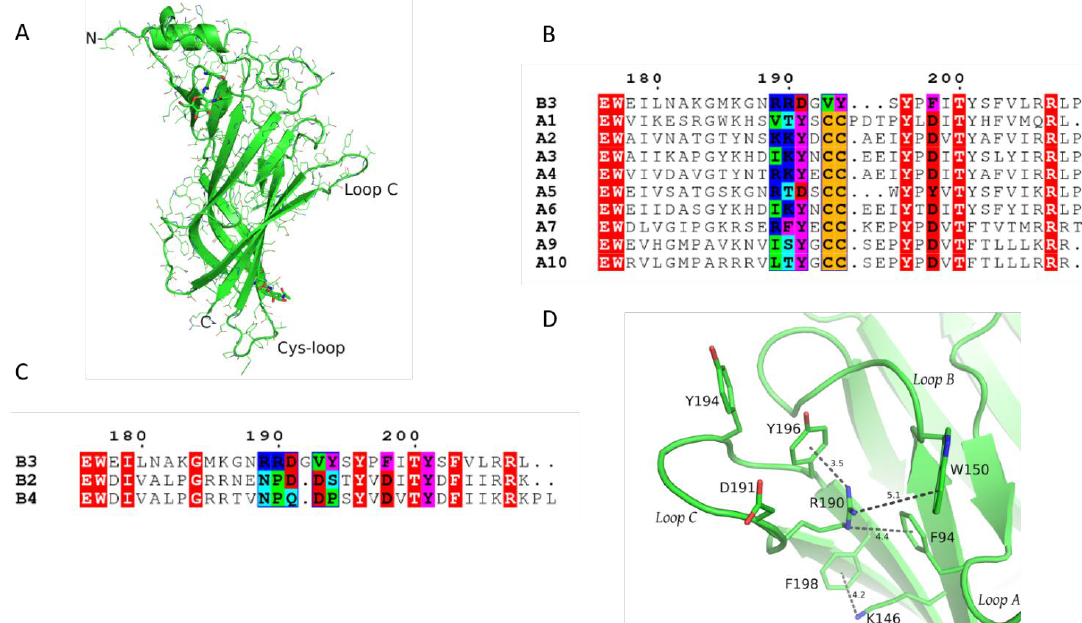
Figure 1. The crystal structure of β 3 ECD and its sequence features. ( A ) The structure of β 3 ECD retains the overall structural characteristics of all members of the pLGIC superfamily. The GlcNAC residues are shown in stick representation. ( B ) Sequence alignment of the β 3 176–209 domain with the corresponding domains of all nAChR α subunits. The invariant residues are in white fonts and highlighted in red. The loop C residues of interest are highlighted in different colors, based on their physicochemical properties (positively charged residues shown in blue, negatively charged shown in red, hydrophobic shown in green, aromatic residues shown in magenta and polar residues shown in cyan). The residues lying on the tip of loop C of all α subunits are shown in orange. ( C ) Sequence alignment of the β 3 176–209 domain with the corresponding domains of β 2 and β 4 subunits. The color coding is as in B. ( D ) The unique interaction scheme found in β 3 ECD crystal structure. Arginine 190 rams the orthosteric (+) binding site being stabilized with interactions with the conserved aromatic